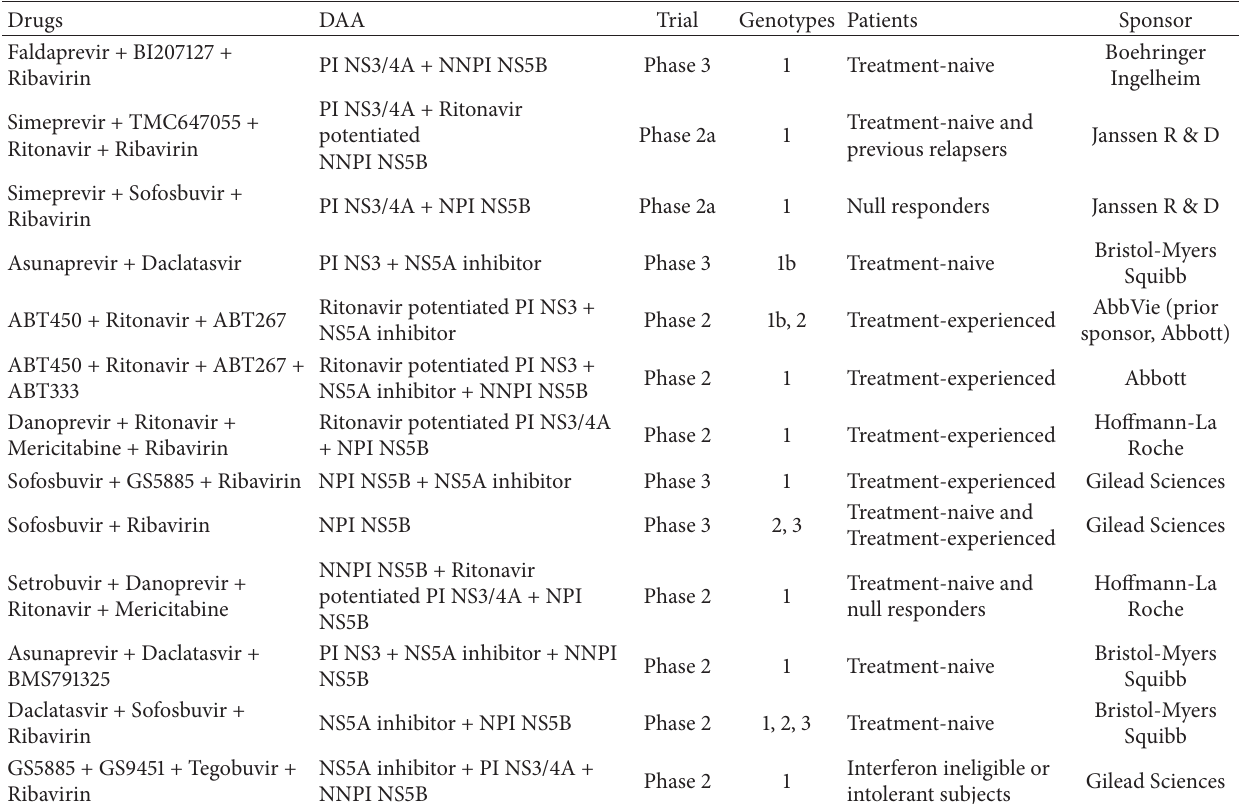
Table 3: Clinical trials ongoing using IFN-free